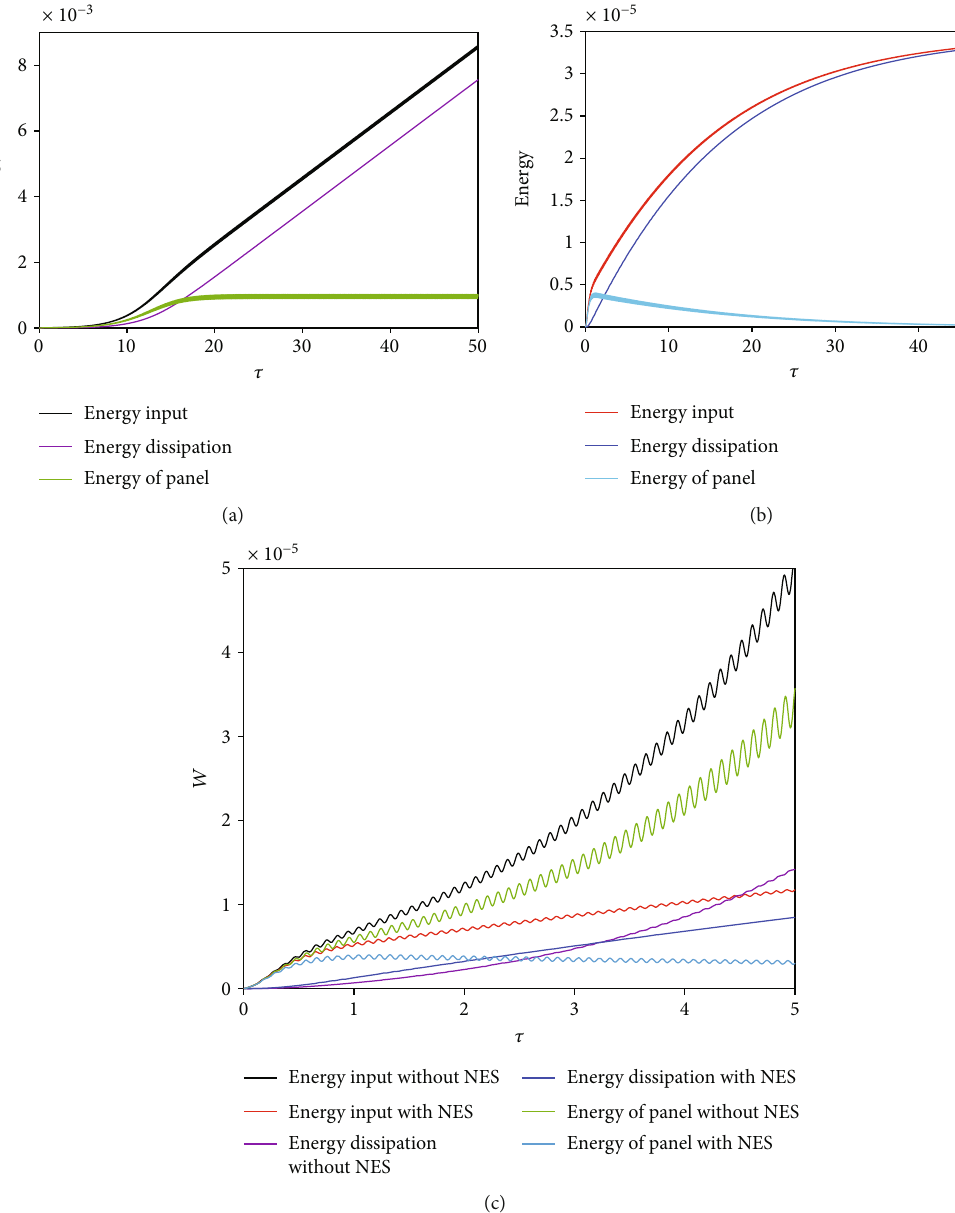
Figure 7: Time history of energy: (a) without an NES, (b) with an NES, and (c) comparisons in time